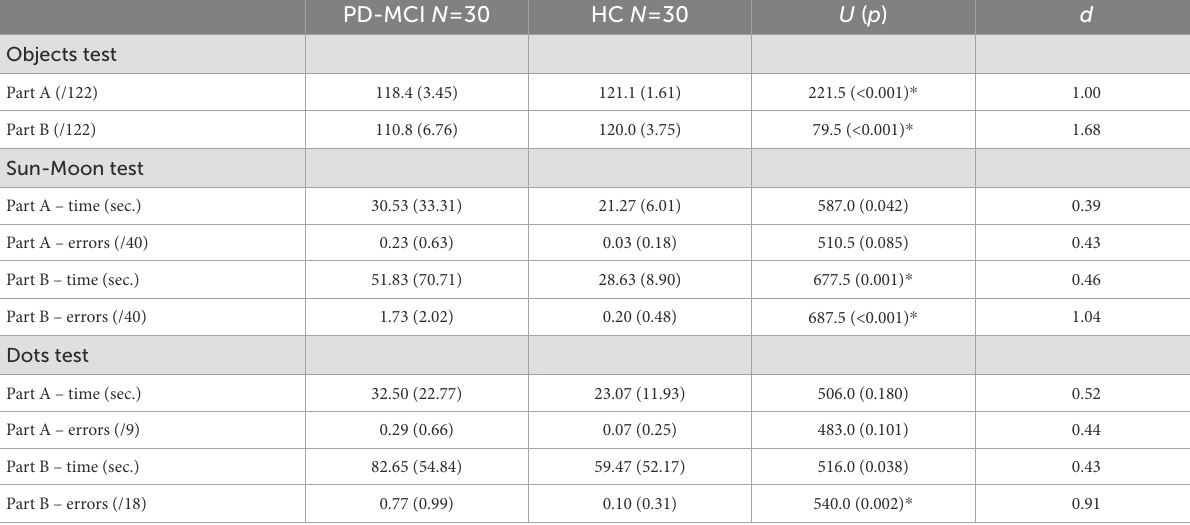
TABLE 3 Intergroup differences on CCD scores for PD and HC